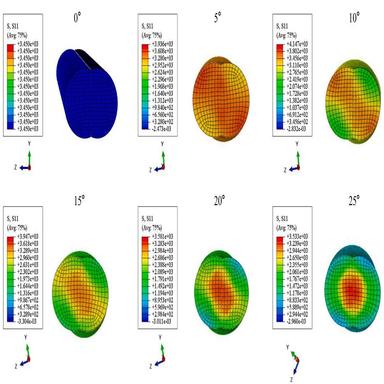
Stress distribution of carbon fiber tows with different twist angles for intersecting circular cross-section models.